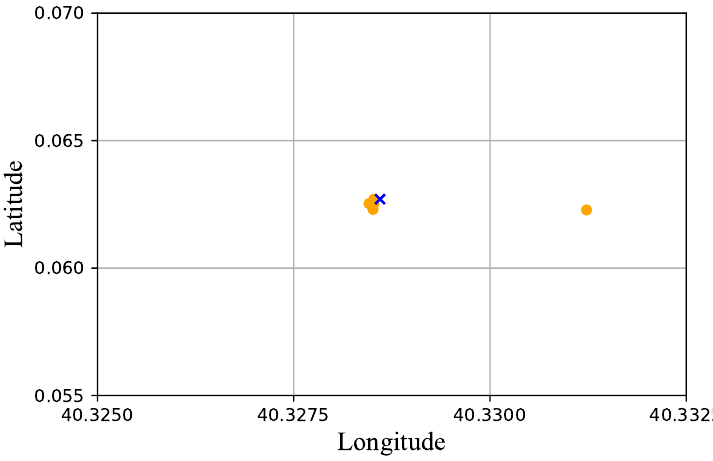
Figure 2. Diagram of the relationship between a shop and customer latitude and longitudes includ- ing